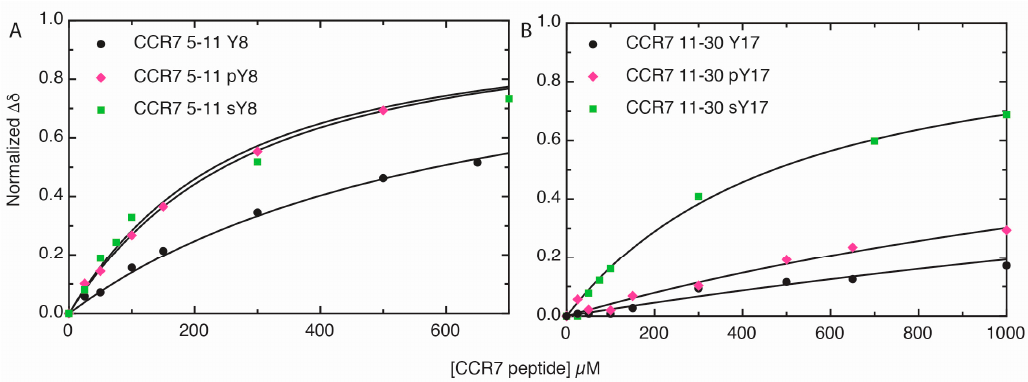
Figure 4. Tyrosine modification increases affinity of CCR7 N-terminal peptides for CCL21. Nonlinear fitting of residues with significant chemical shift perturbations was used for dissociation constant (K d ) determination. Nonlinear fitting also provided the maximum chemical shift, which was normalized to 1 in the figure for better visual comparison. ( A ) Nonlinear fitting of normalized, combined amide chemical shift perturbations for CCL21 K69, a representative residue, plotted versus CCR7 peptide concentration. For this residue only, the K d values were as follows: CCR7 5–11 K d = 530 ± 40 μ M, CCR7 5–11 pY8 K d = 240 ± 90 μ M, CCR7 5–11 sY8 K d = 180 ± 40 μ M; ( B ) Nonlinear fitting of normalized, combined amide chemical shift perturbations for CCL21 A53, a representative residue, plotted versus CCR7 peptide concentration. For this residue only, the K d values were as follows: CCR7 11–30 K d = Table 1. CCR7 N-terminal modifications enhance CCL21 binding affinity.